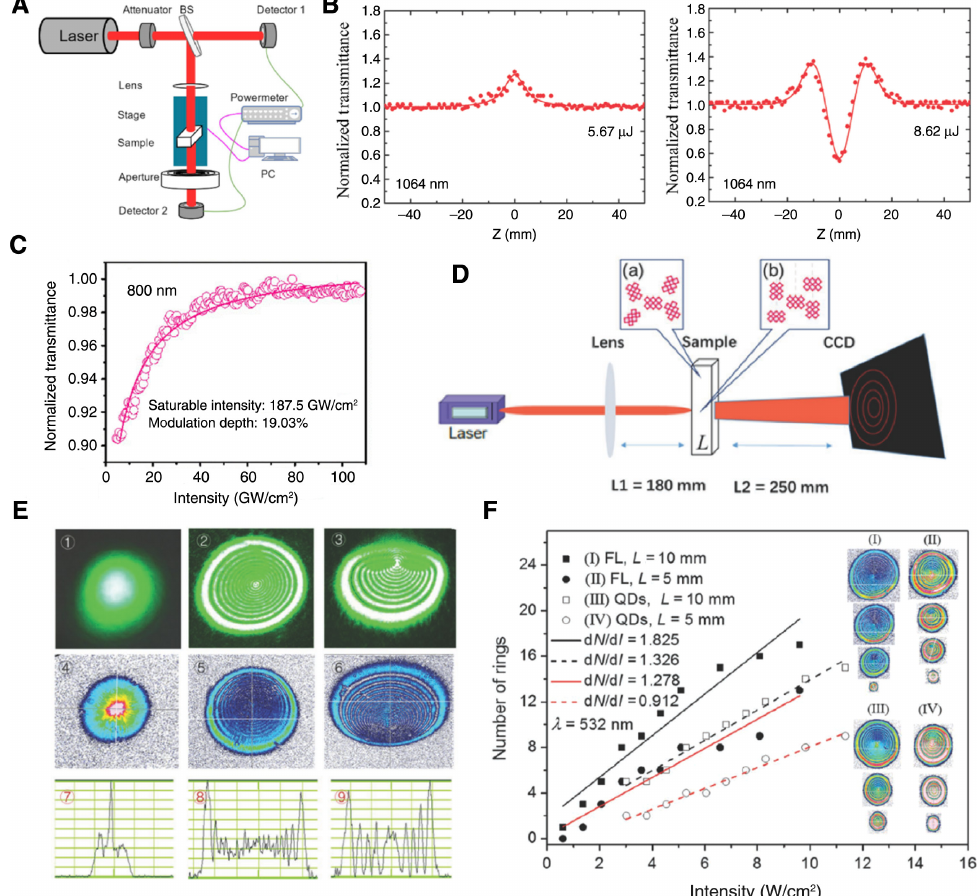
Figure 7: The measurements for nonlinear optical behavior of antimonene. (A) The schematic diagram of experimental setup of open-aperture Z-scan measurement for nonlinear saturable absorption